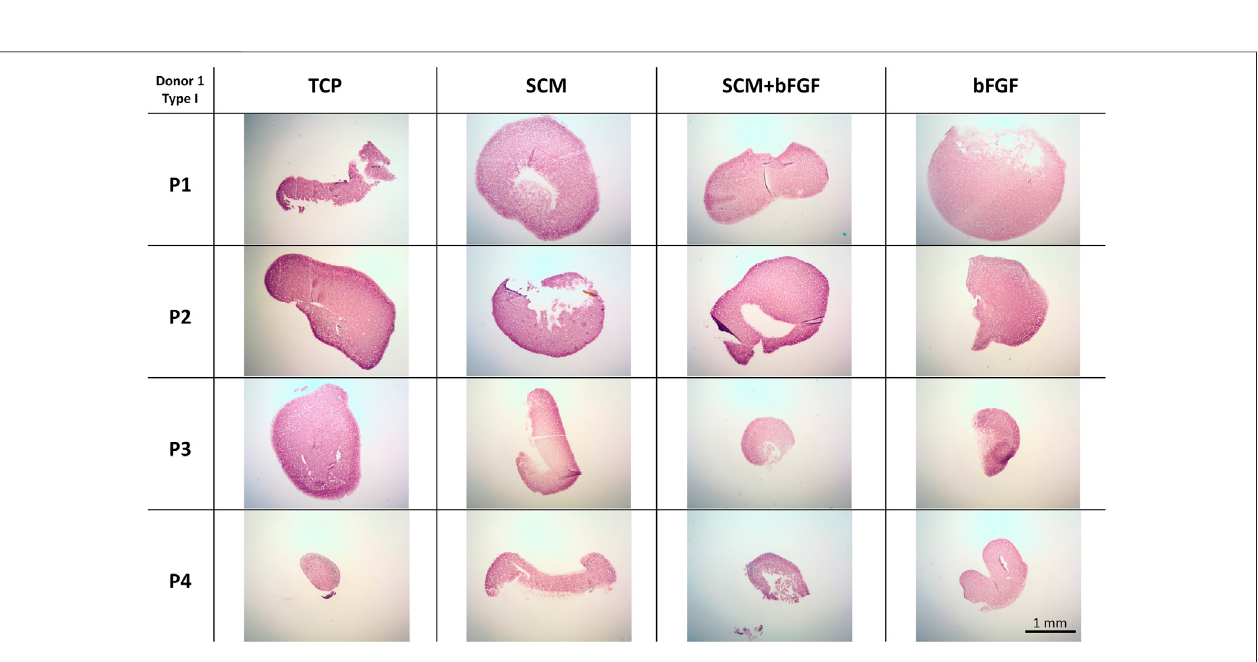
Frontiers in Bioengineering and Biotechnology |